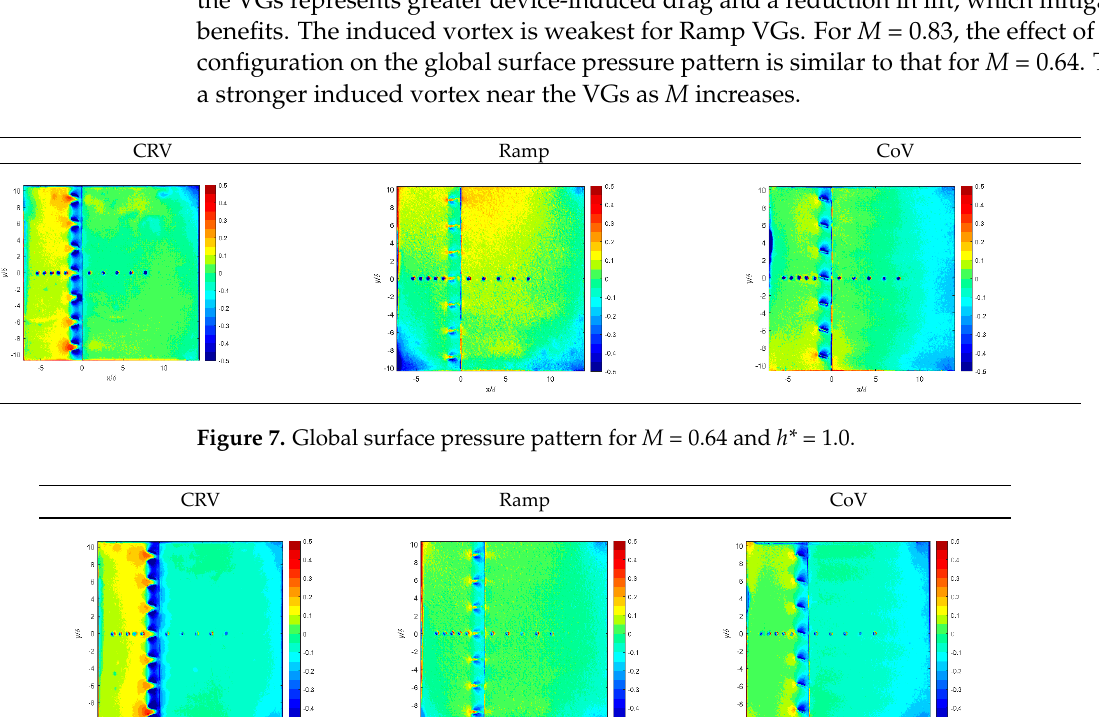
Figure 6. The calibration curve for UniFIB PSP.